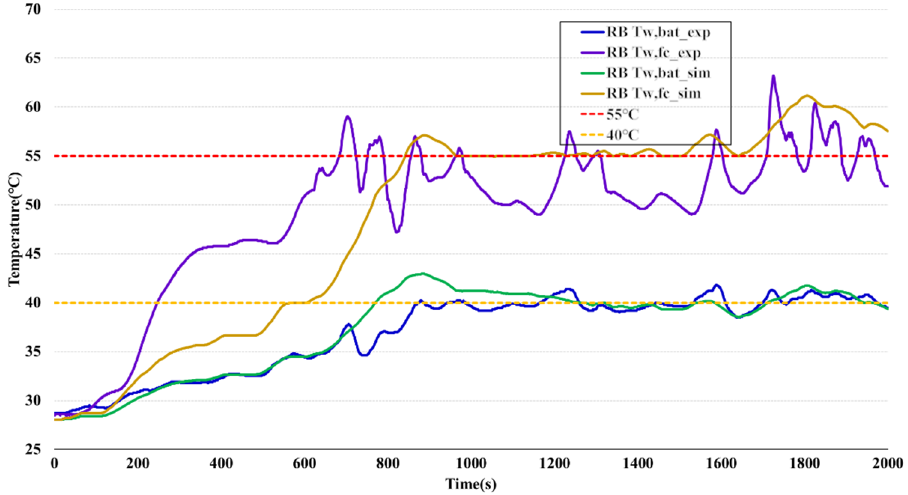
Figure 9. Simulation/experiment comparison of coolant temperature variations of two energy sources.